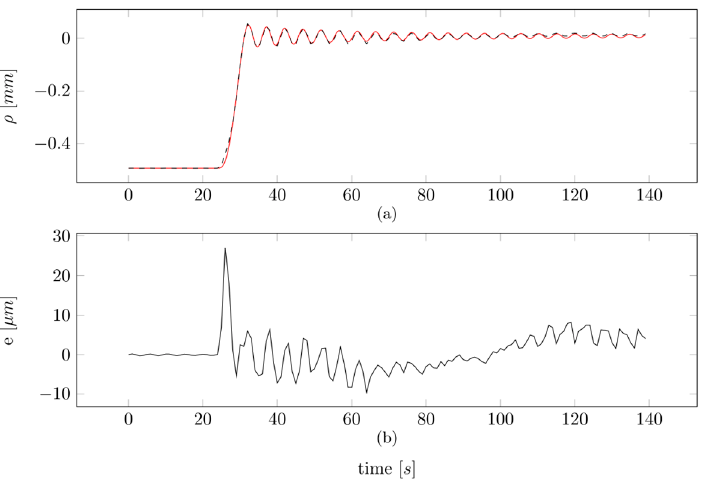
Figure 16. Simulation results (red, solid) and measurement data (black, dashed) for a single droplet ( a ) when combined with the simulation error e ( b ); when the error is in the single-digit percentage range.